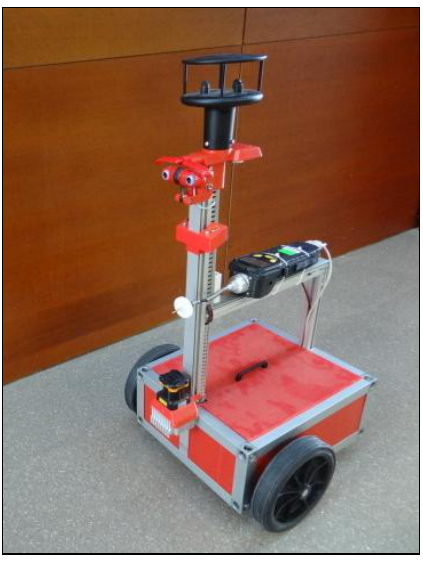
Figure 1. Assistant mobile